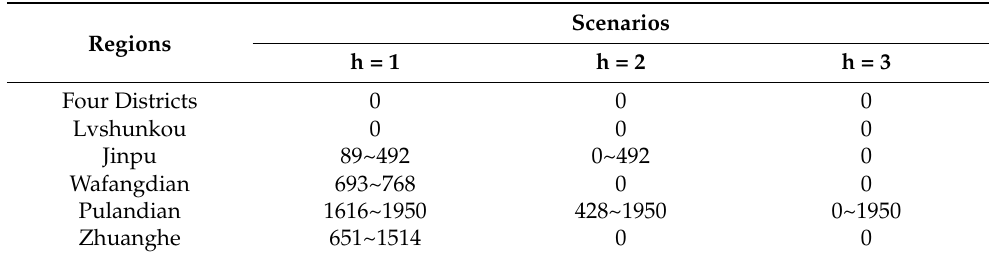
Table 8. Upper and lower bounds of water resource deficit for ecological environment sector under different scenarios in period 2.